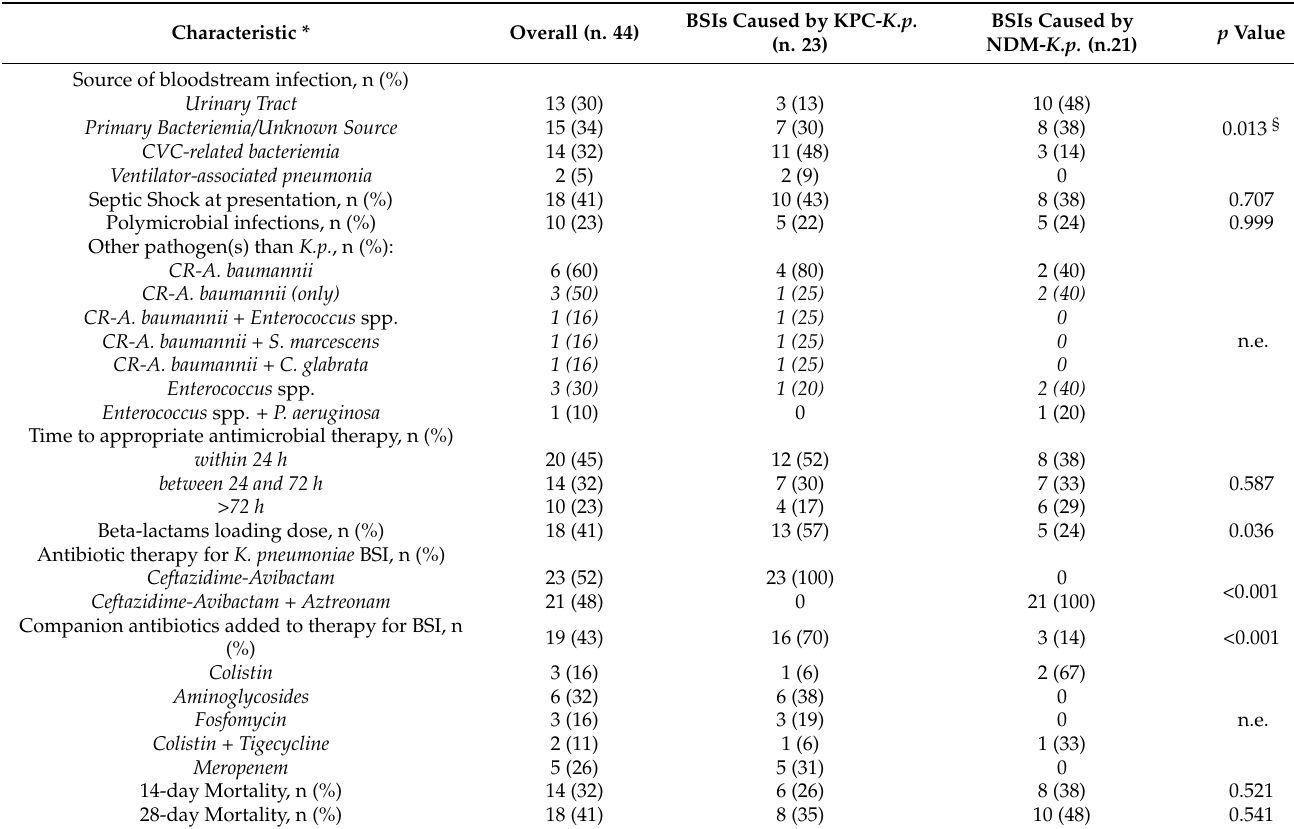
Table 2. Characteristics of BSIs and antibiotic therapies